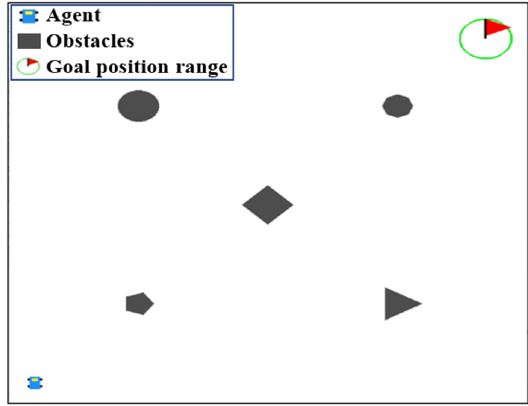
Figure 2. Example of a fixed location scene.